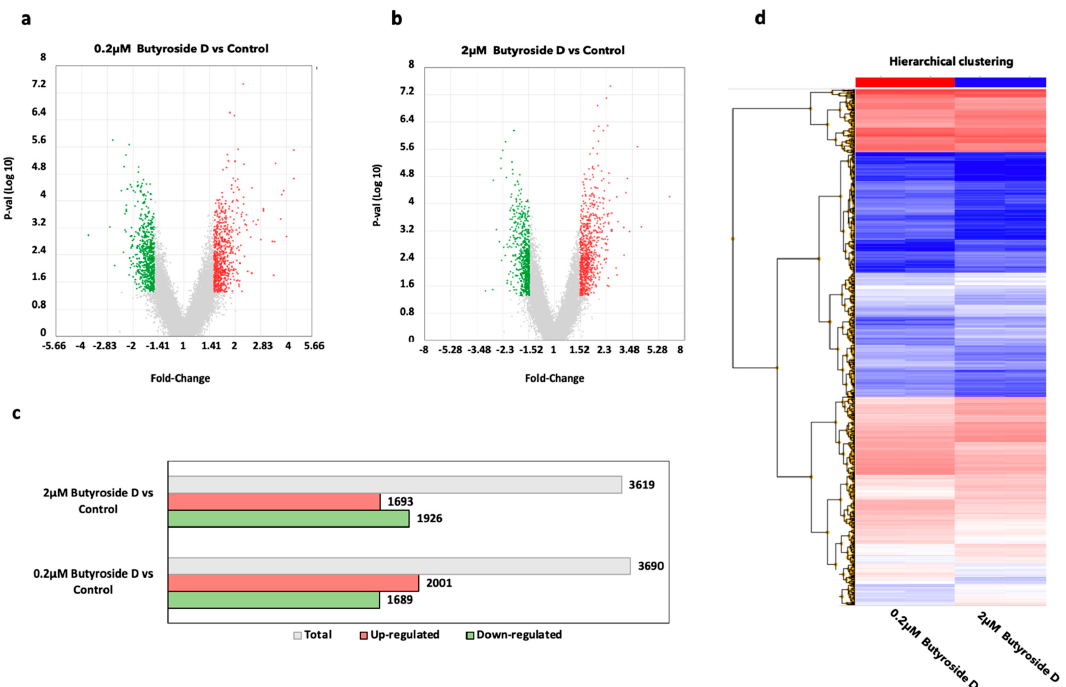
Figure 3. Butryoside D promoted differential expression of genes in B16F10 cells. ( a , b ) Volcano plots displaying the DEGs regulated between 0.2 and 2 μ M Butryoside D versus control, respectively. The x -axis represents the fold change of the DEGs whereas the y -axis represents the log 10 ( p -value). The green dots represent the downregulated genes, red dots are for the upregulated genes, and the gray dots are the unreguated genes. ( c ) Bar graph showing the total number of regulated DEGs by 0.2 and 2 μ M Butryoside D. DEGs were selected according to the fold-change criteria of >1.5 and < − 1.5. The x -axis represents the number of DEGs and the y -axis shows the groups. Red bar indicates the upregulated genes, green bar indicates the downregulated genes, and gray bar represents the total number of DEGs regulated in each group. ( d ) The heatmap of DEGs following the hierarchical clustering analysis. The x-axis shows the sample groups which are 0.2 and 2 μ M Butryoside D while the y -axis represents the DEGs. Red bars represent the upregulated genes and blue indicates downregulated genes.